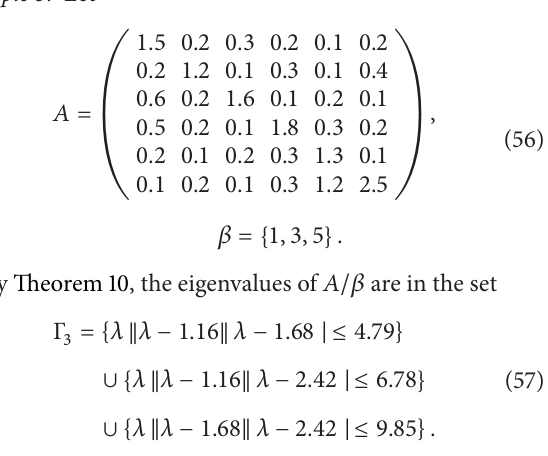
Figure 2: The red dotted line and black dashed line denote the corresponding discs Γ 2 and Γ 󸀠 2 , respectively.